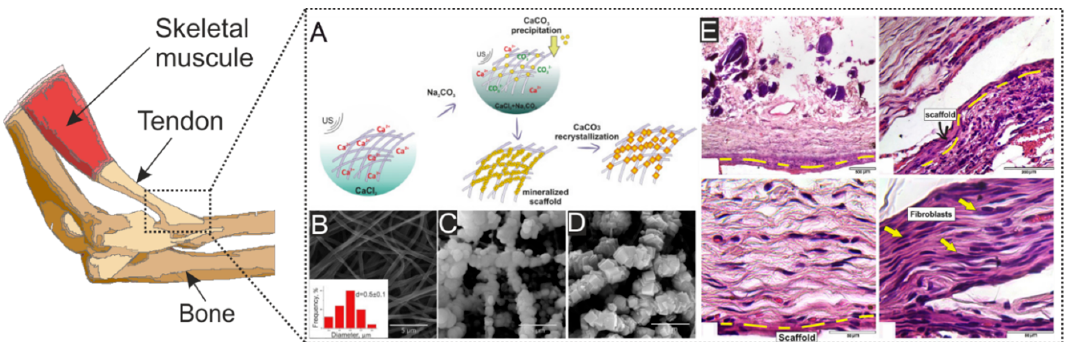
Figure 2. ( A ) Scheme of ultrasonic mineralization of polycaprolactone fibers and recrystallization of vaterite to calcite. ( B ) Microphotographs show pristine PCL fibers. ( C ) the mineralized scaffold based on PCL material. ( D ) process of recrystallization vaterite to calcite. ( E ) Micrograph of histological sections, 21 days after implantation in the withers of the mouse. Yellow dashed lines indicate the location of the matrix. Reprinted with permission from Elsevier, 2018 [138].